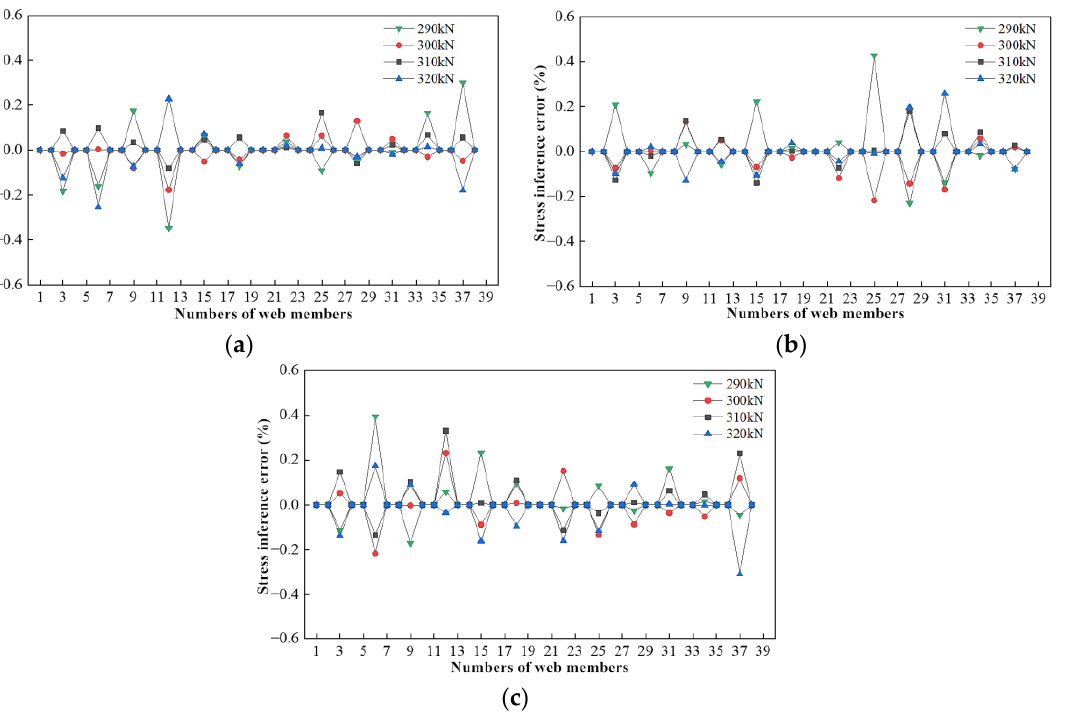
Figure 6. Stress inference error in case 1: ( a ) with the load applied on node 4; ( b ) with the load applied on node 11; ( c ) with the load applied on node 18.